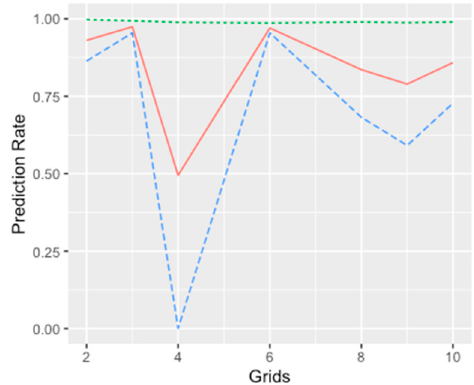
Figure 7. The prediction rate under di ff erent spatial units, where the green, red, and blue represent overall, true negative and true positive, respectively.